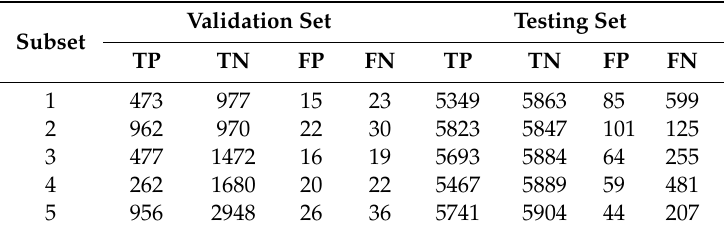
Table 5. Detection results of the validation set and testing set (one of five runs).